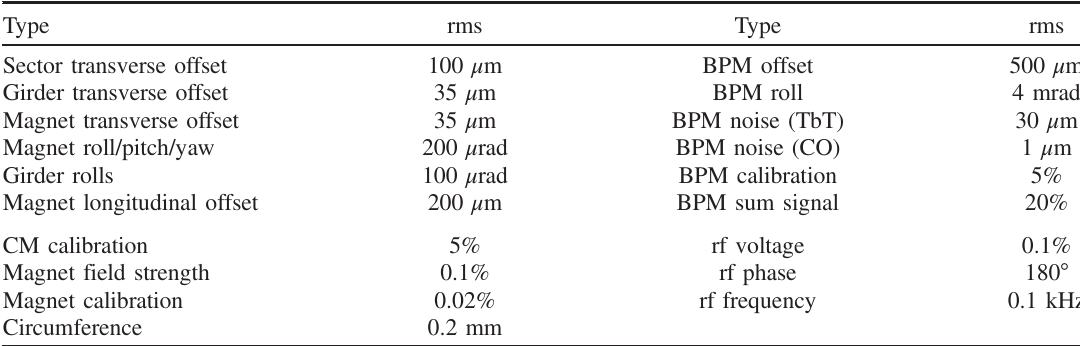
TABLE III. Magnet misalignments and other errors (rms). Typical error distributions applied in simulations are truncated 2 σ Gaussians, though magnet and girder transverse misalignments are truncated at (cid:1) 3 σ .